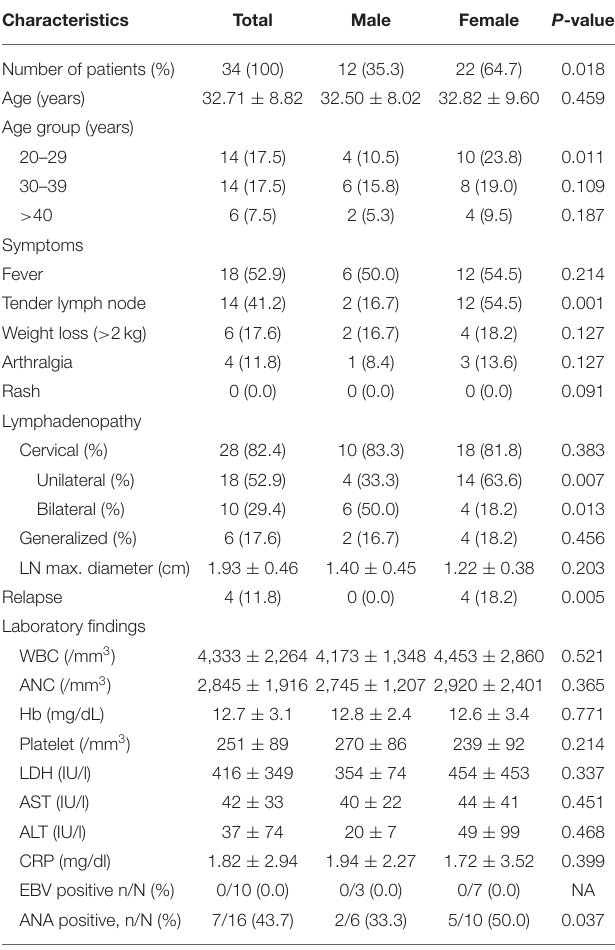
TABLE 3 | Manifestations of Kikuchi-Fujimoto disease in adults by sex.